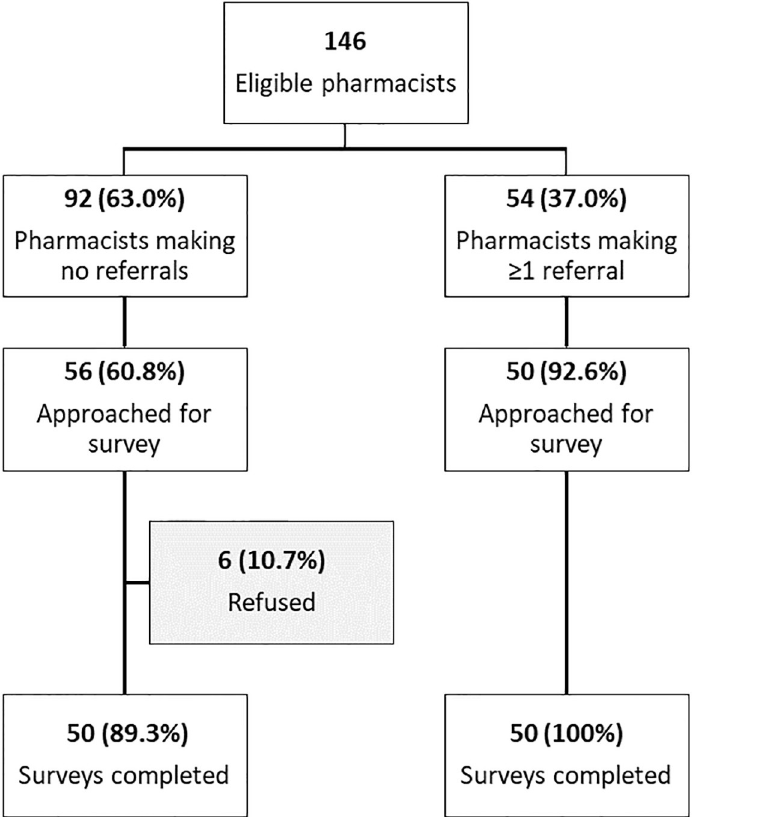
Fig 1. Flow diagram of pharmacist recruitment for the acceptability